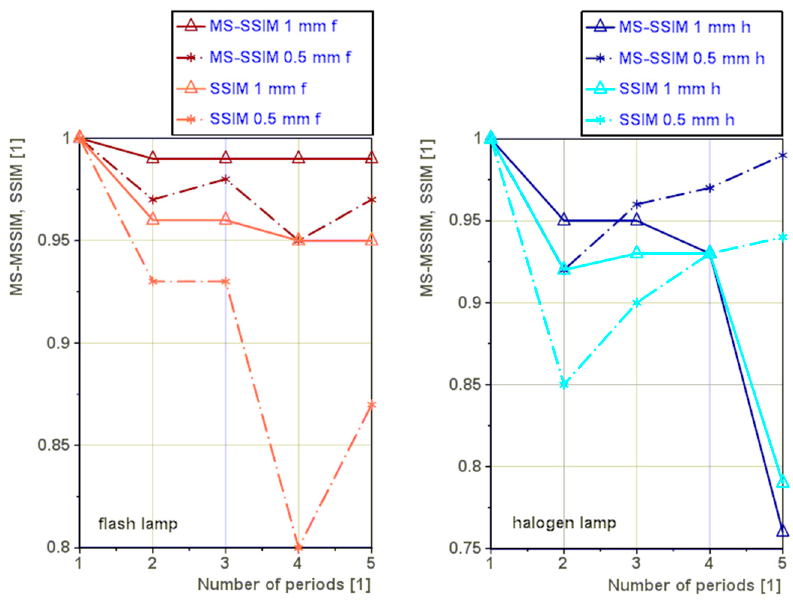
Figure 13. Comparison of the dependence of the MS-SSIM and SSIM indices on the number of periods on the left side for flash lamp excitation and on the right side for halogen lamp excitation.